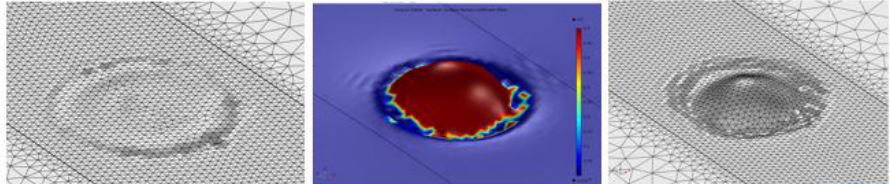
Figure 4. Process of an Automatic Remeshing. Departing from the initial mesh ( left ), the drop formation starts ( center ), and, when a high value of distortion in any element is reached, a new mesh is built, based on the deformed geometry ( right ).